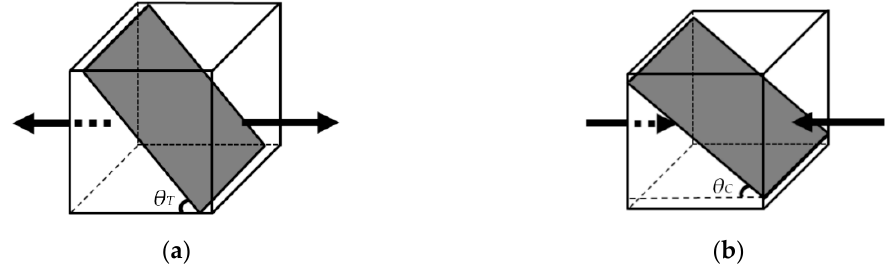
Figure 4. Fracture angles of metallic glass under uniaxial tension and compression [7]. ( a ) Uniaxial tension, θ T = 50.7 ◦ ; ( b ) uniaxial compression, θ C = 43.0 ◦ .